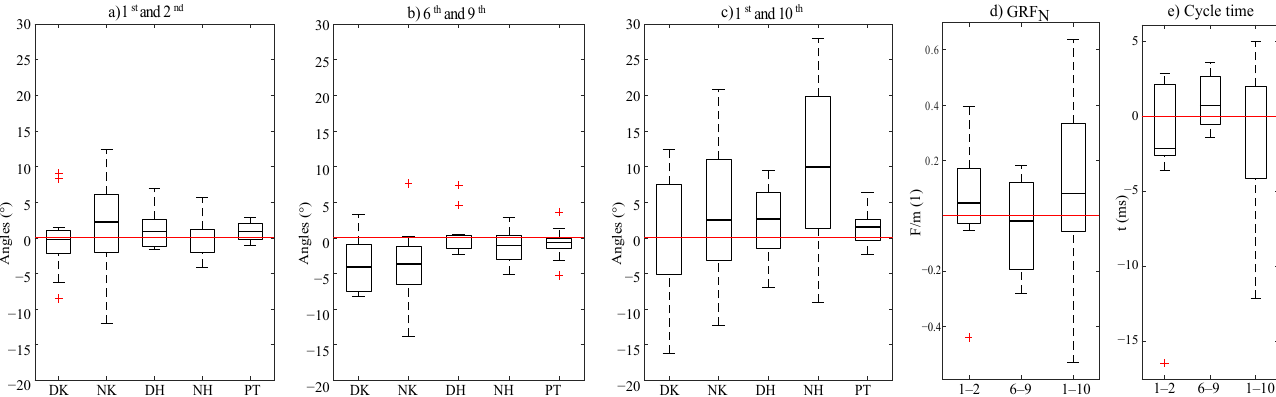
Figure 3. ( a – c ) show the differences between the dance sequences of the average values of the angular parameters. ( a ) shows the differences between the 1st and the 2nd sessions, ( b ) shows the differences between the 6th and the 9th sessions, and ( c ) shows the differences between the 1st and the 10th sessions. In the 4th diagram ( d ), the normalized ground reaction force is depicted (1st and 2nd, 6th and 9th, and 1st and 10th sessions), whereas the 5th ( e ) shows the differences between the dance sequences (1st and 2nd, 6th and 9th, and 1st and 10th sequences) in the case of the average cycle time. The numeric data are detailed in Supplementary Material